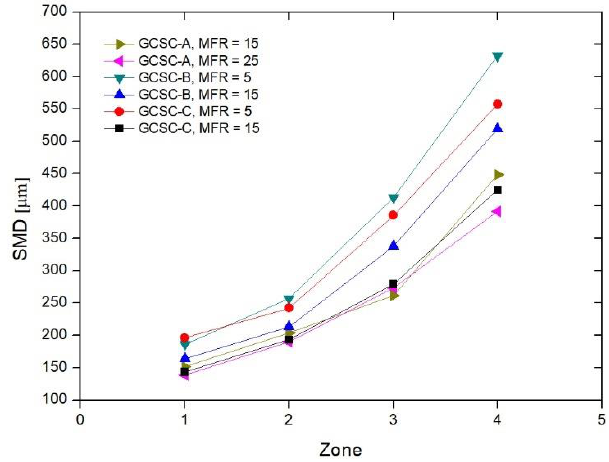
Figure 10. SMD of injectors under firing test conditions.